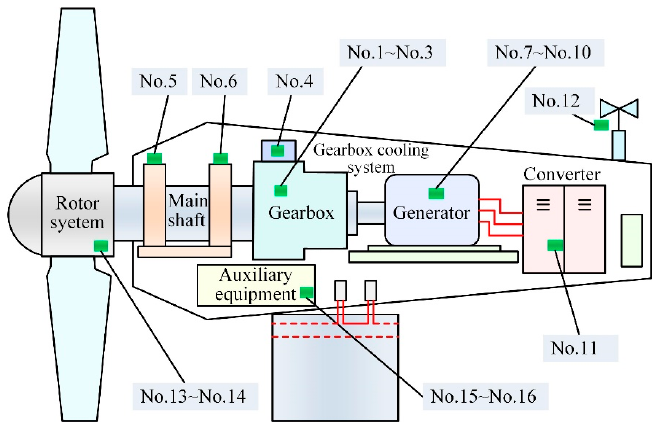
Figure 1. The main components and sensor positions of the considered wind turbine (WT).